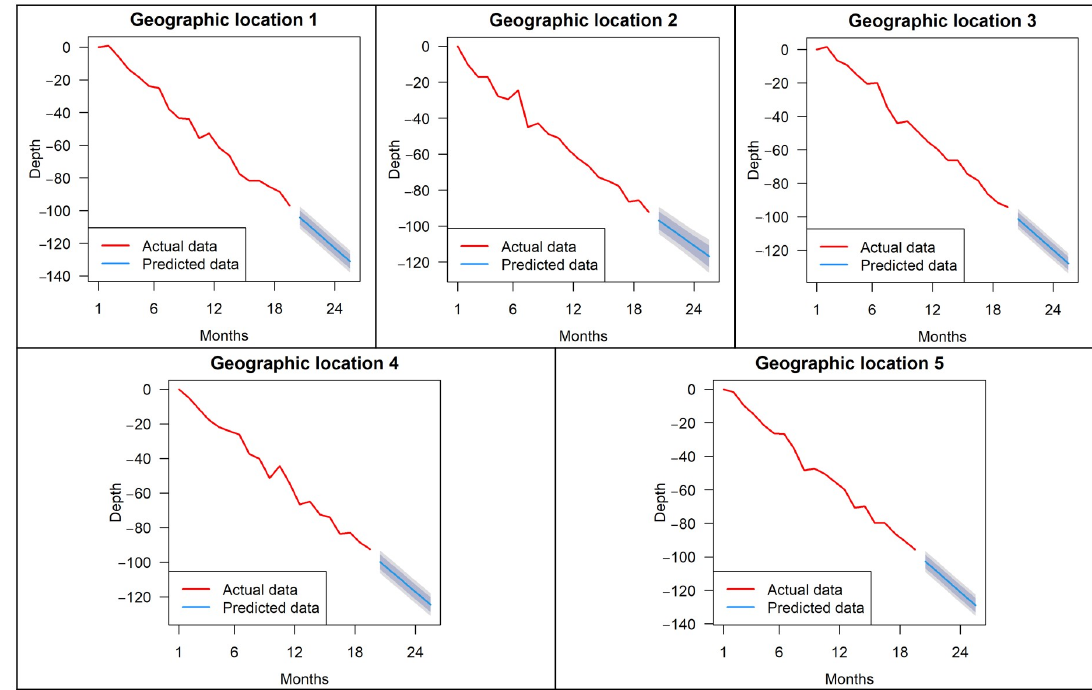
Figure 14. Holt ′ s smoothing model prediction results (Unit: mm).